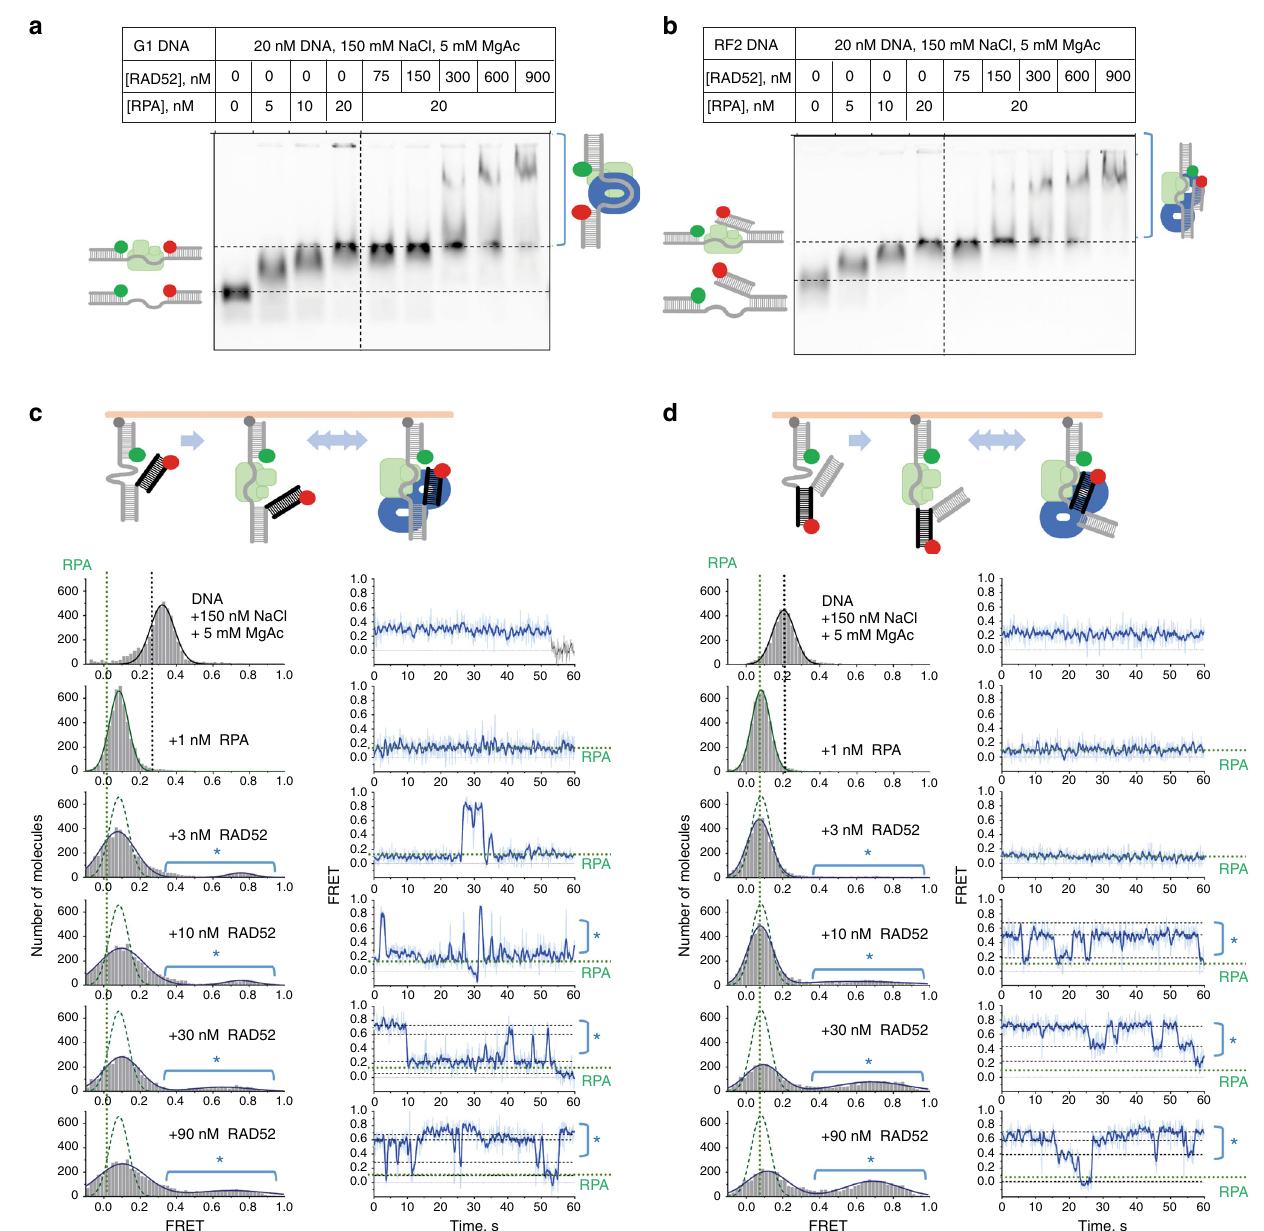
Fig. 4 RAD52 promotes formation of a reversal-resistant fork structure. a , b Electrophoretic mobility shift analysis of the RPA and RAD52 binding to G1 DNA ( a ) and a model replication fork, RF1 ( b ). DNA substrates were incubated with the indicated concentrations of RPA and RAD52. The complexes and the unbound DNA were then separated by electrophoresis in 0.8% TAE agarose. c , d Single-molecule analysis of the replication fork-like structures in the presence of RPA and RAD52. RF2 ( c ), which reports on the conformation and motion of the leading strand (black) arm relative to the lagging strand arm tethered to the surface, and RF3 ( d ), which reports on the relative position and dynamics of the parental duplex (black) relative to the surface-tethered lagging strand arm, were immobilised on the surface of the TIRFM fl ow cell. The Cy3 dye (green circle) was excited by 532 nm TIR illumination, while the Cy5 dye (red circle) was excited via Förster resonance energy transfer (FRET) from Cy3. Fluorescence of the Cy3 and Cy5 dyes was recorded separately and used to calculate FRET ef fi ciency. FRET distributions in the left column of each panel were obtained from combining three short movies and represent the overall FRET states of each substrates under the indicated conditions. Dotted green lines show the FRET distribution for each substrate in the presence of RPA only overlaid over the distribution in the presence of RPA and RAD52. Regions of the distributions marked by a blue star indicate states where the Cy5-labelled arm is brought close to the Cy3-labelled lagging strand arm. Movies recorded for 1 min were used to evaluate the conformational dynamics of the RF2 and RF3 under each experimental condition. Representative single-molecule FRET trajectories are shown in the right column by their respective FRET distributions. Source data are provided as a Source Data fi